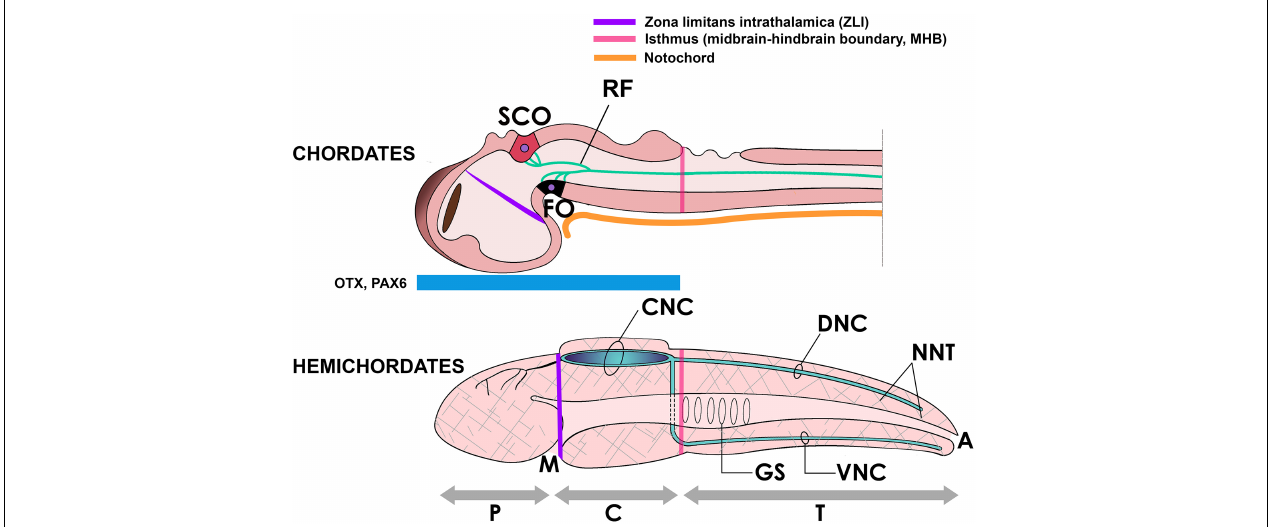
FIGURE 4 | Above, the neural tube of a chordate (embryonic fish) showing the subcommissural organ (SCO) and the flexural organ (FO), sites of origin of RF. These organs are located in the mesencephalic-diencephalic boundary, which is included in the embryonic region bound by the zona limitans intrathalamica (ZLI) anteriorly and the midbrain-hindbrain boundary (MHB) posteriorly. This region is strongly Otx-positive in early development and for this reason has been considered homologous to the location of the collar region (C) of the hemichordate body (below), displaying the same morphogenetic boundaries (ZLI and MHB homologs) and containing a hollow collar nerve cord (CNC) (Pani et al., 2012; Lowe et al., 2015). Beside the CNC, hemichordates display dorsal and ventral nerve cords (DNC, VNC) in the body trunk (T) and a diffuse neural network (NNT, hatched areas) covering the body (Holland et al., 2015). A, anus; GS, gill slits; M, mouth; P,